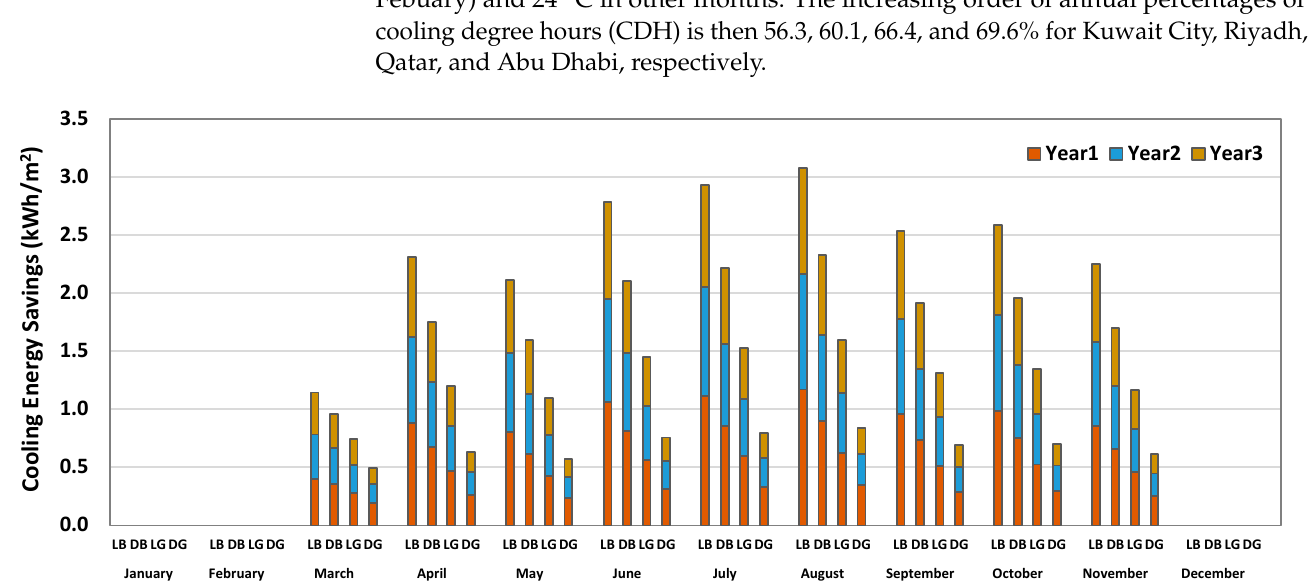
Figure 20. Monthly energy savings contributions of walls colored with high SRI paints. The results in Figure 21 indicate the annual cooling energy savings (COP-2.852) con- (Y1, 2, and 3) after roof retrofit ranged between 12.4–25.6 kWh/m 2 of building roof area.